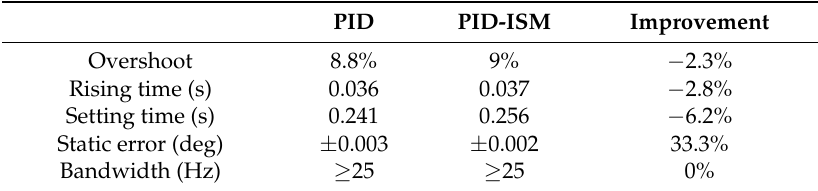
Table 3. Dynamic Response Index.